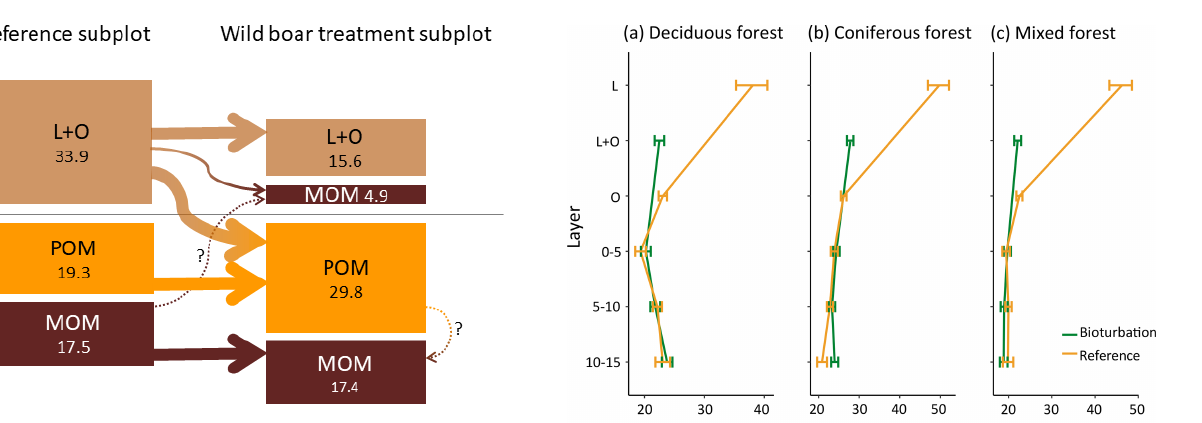
Figure 5. Changes in different soil organic carbon (SOC) pools in the forest floor (L and O horizons) and the underlying mineral soil (0–10cm depth) due to bioturbation. Average carbon stocks for all 23 plots (MgSOCha − 1 ). POM: particulate organic matter, MOM: mineral-associated organic matter.